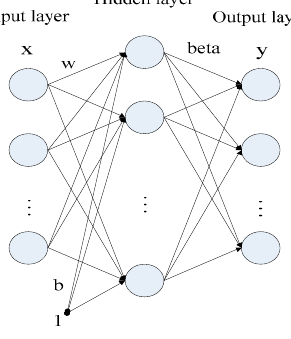
Figure 1. The topology of the extreme learning machine (ELM).